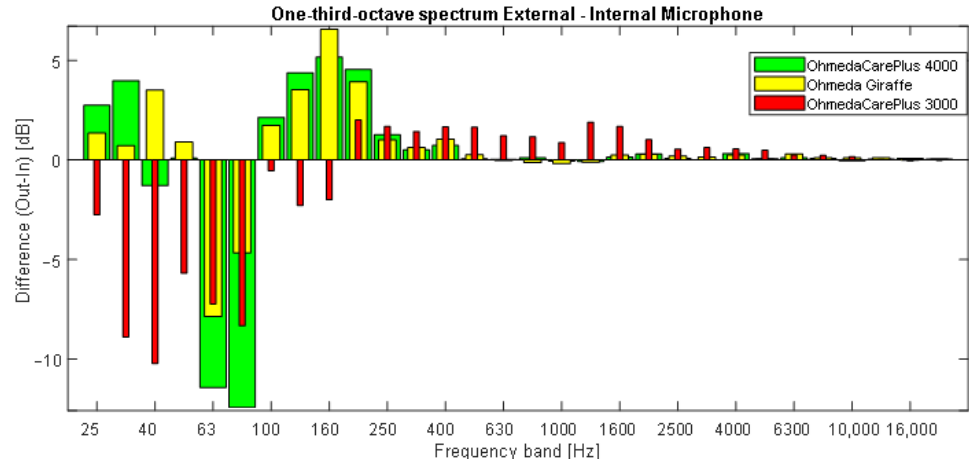
Figure 1. Background noise (Incubators off). Spectral difference between outside and inside the incubator (dB).